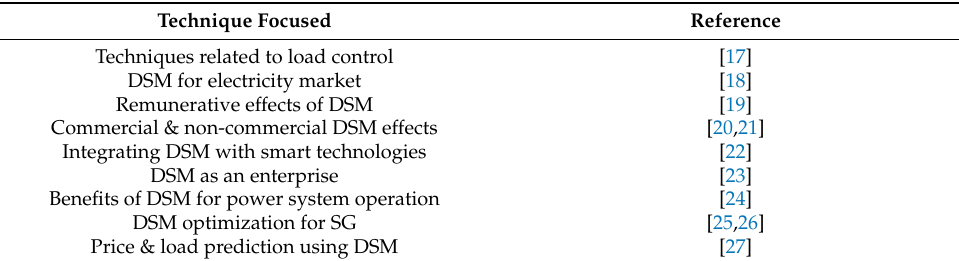
Figure 2. Architecture of MG. Table 2. DSM and its